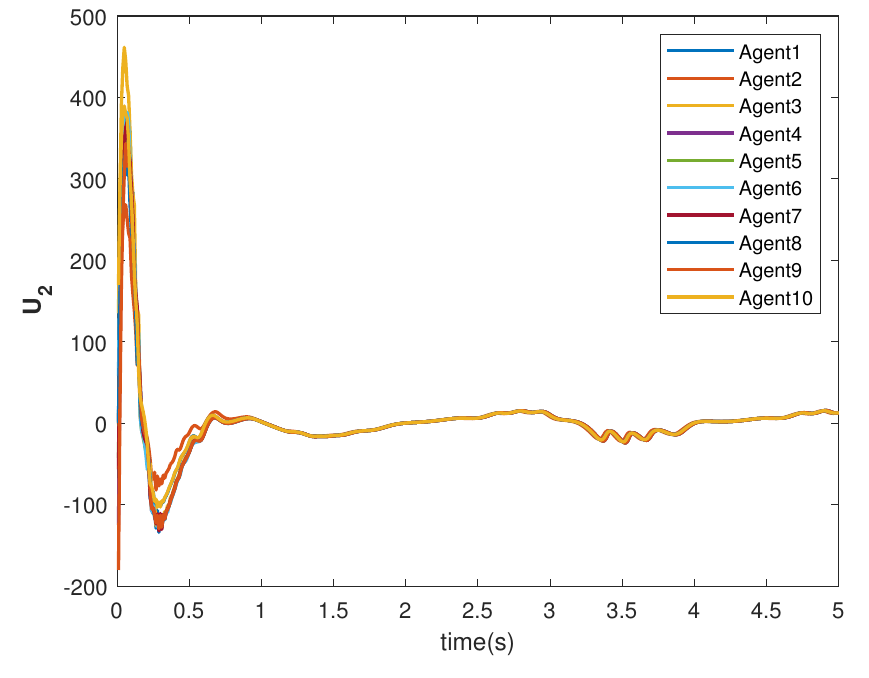
Figure 8. Control U 2 of agents.